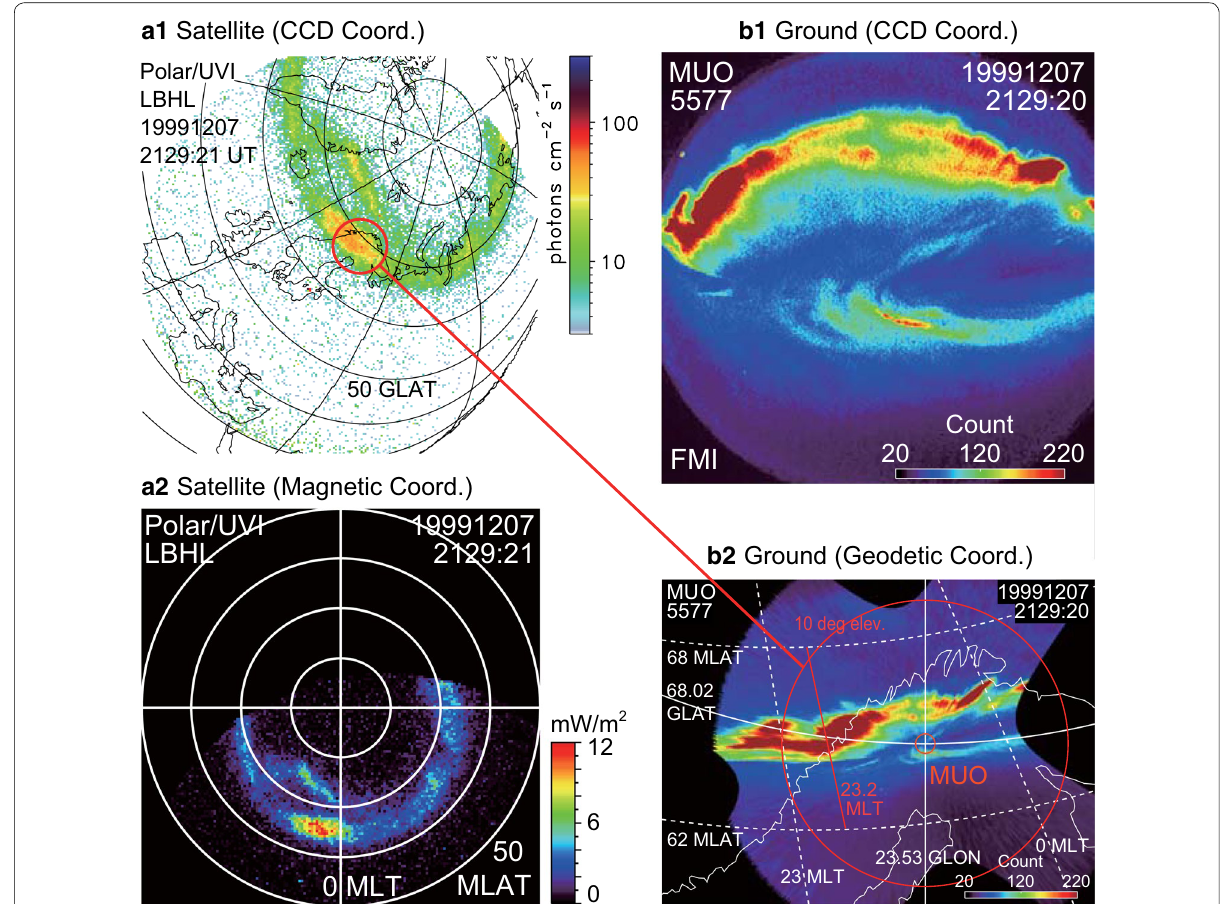
Fig. 2 Example of simultaneous satellite-based global images and ground-based all-sky images. These images were observed at 2129 UT on December 7, 1999. a1 Polar satellite global image in the raw (CCD) coordinates with an overlaid geographical map. Auroral emission at ultraviolet 170 nm (LBHL) is shown. a2 The same satellite image as ( a1 ) but in the magnetic coordinates (i.e., the modified APEX coordinates). b1 Ground-based all-sky image observed at Muonio (MUO, 64.6 MLAT, 105.2 MLON, 68.02 ◦ N , 23.53 ◦ E ) in Lapland, Finland, in the raw (CCD) coordinates. Auroral emission at 557.7 nm (green-line) is shown. b2 The same ground image as ( b1 ) but in the geodetic coordinates (the azimuthal equidistant projection), trimmed at the elevation angle of 5 ◦ . The dashed white lines indicate MLT and MLAT reference lines. The red line indicates the substorm onset MLT (23.2 h), from where auroral keograms were made later. The red circles in a1 and b2 indicate the field of view of the ground images for the elevation angle of 10 ◦ , corresponding to a diameter of ∼ 1000 km ( ∼ 9 ◦ along latitudes) to the assumed emission altitude of 110